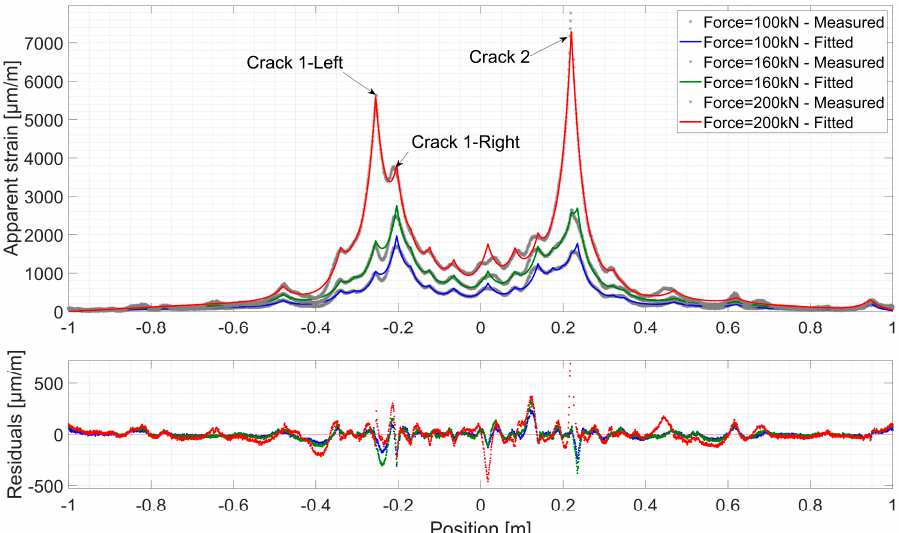
Figure 16. Comparison between the measured and fitted strain profiles and the corresponding residuals over Line 2 of Thorlabs cable.